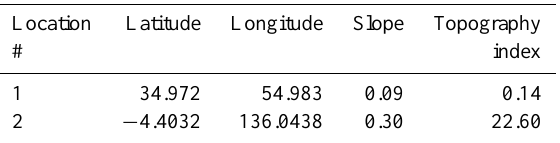
Fig. 2. Schematic view of the model structure. Table 1. Topography index for two areas: The Lut Desert (loca- tion 1), which is flat and not susceptible to landslides; and a moun- tainous region in Indonesia (location 2), which has frequently expe- rienced landslides.